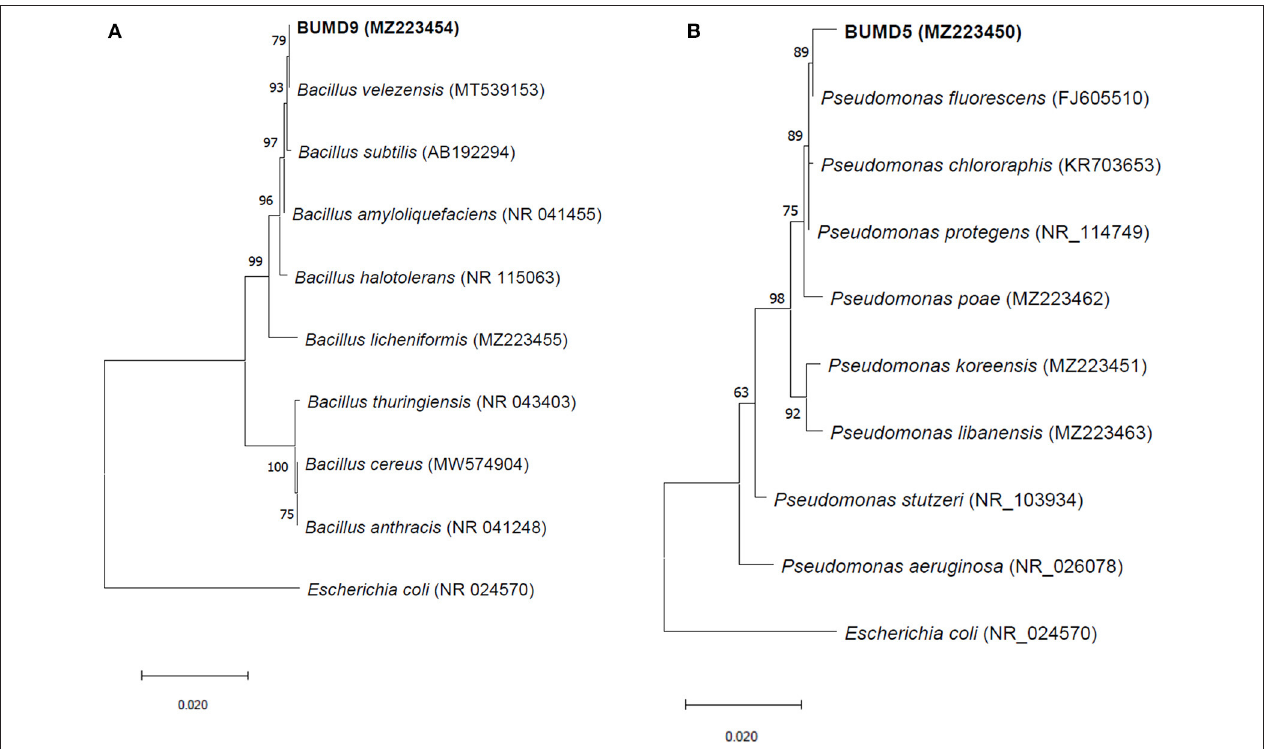
FIGURE 3 | The phylogenetic trees for (A) BUMD9 (MZ223454) and (B) BUMD5 (MZ223450). The tree was constructed using the Neighbor Joining method and Bootstrap value 1,000.